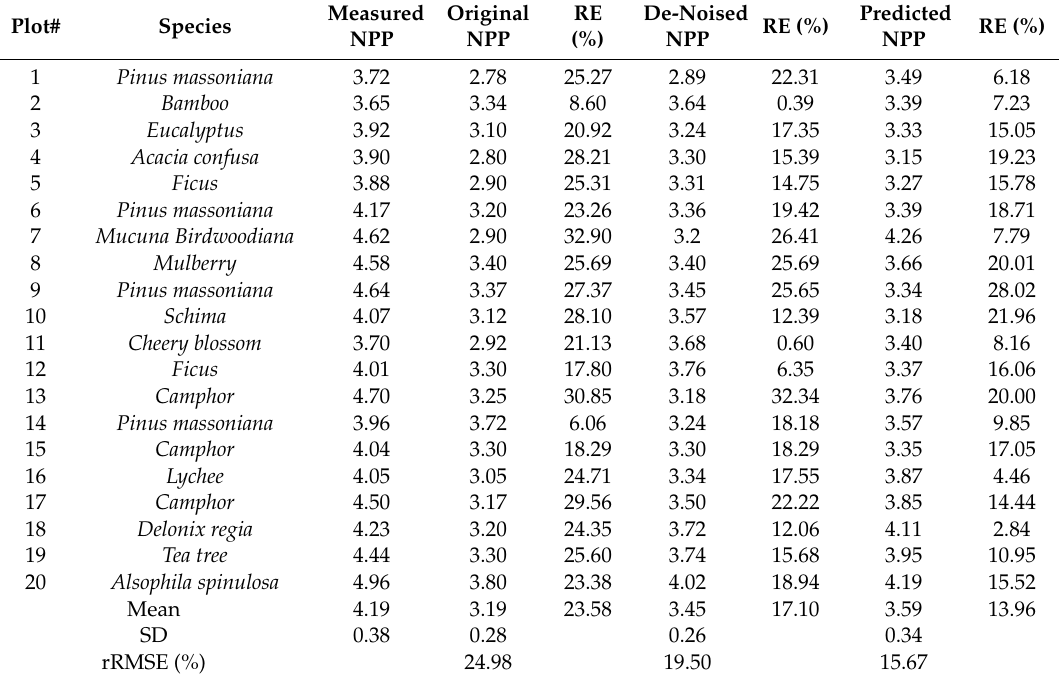
Table 2. Comparison of NPP data between the predicted MODIS-NPP, de-noised MODIS-NPP, original MODIS-NPP, and measured NPP based on field observations of sample plots (NPP units: Mg ha − 1 a − 1